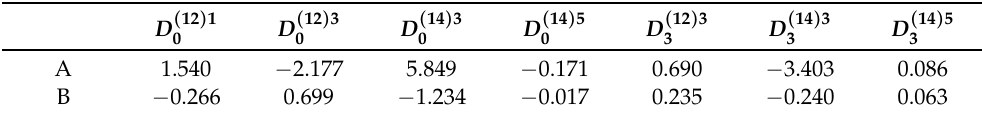
Table 4. The calculated parameter values of the operator of interaction with the electric field (6) in a . u ./ | e |